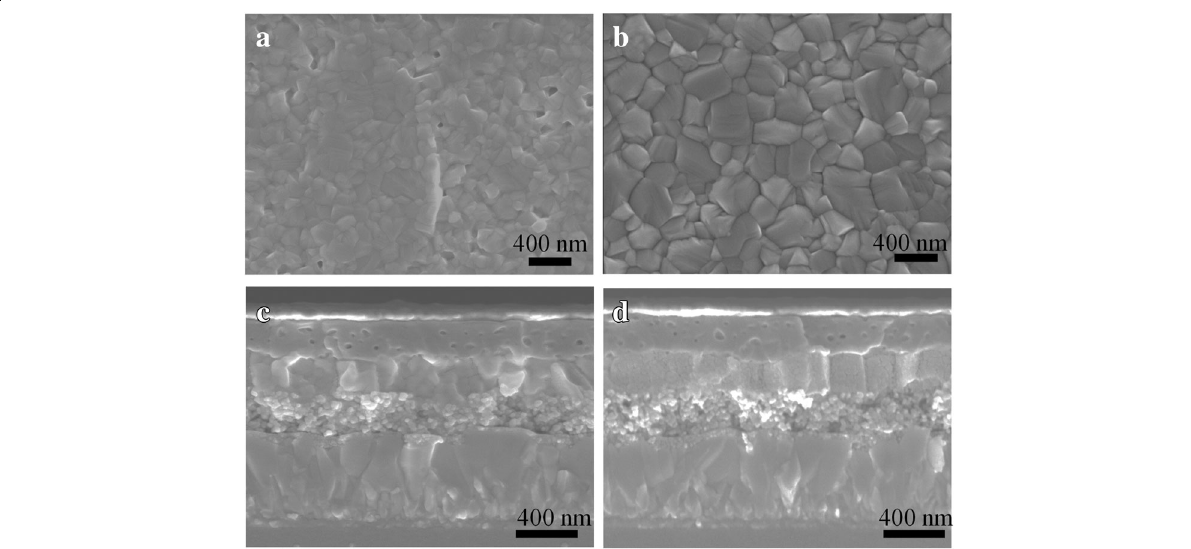
Fig. 3 SEM images of the MAPbI 3 films (top) and corresponding perovskite solar cells (bottom). a , c The perovskite films are prepared from PbI 2 / DMF precursor solution adding with 10 vol% DMI and annealing at 100 °C and b , d at 130